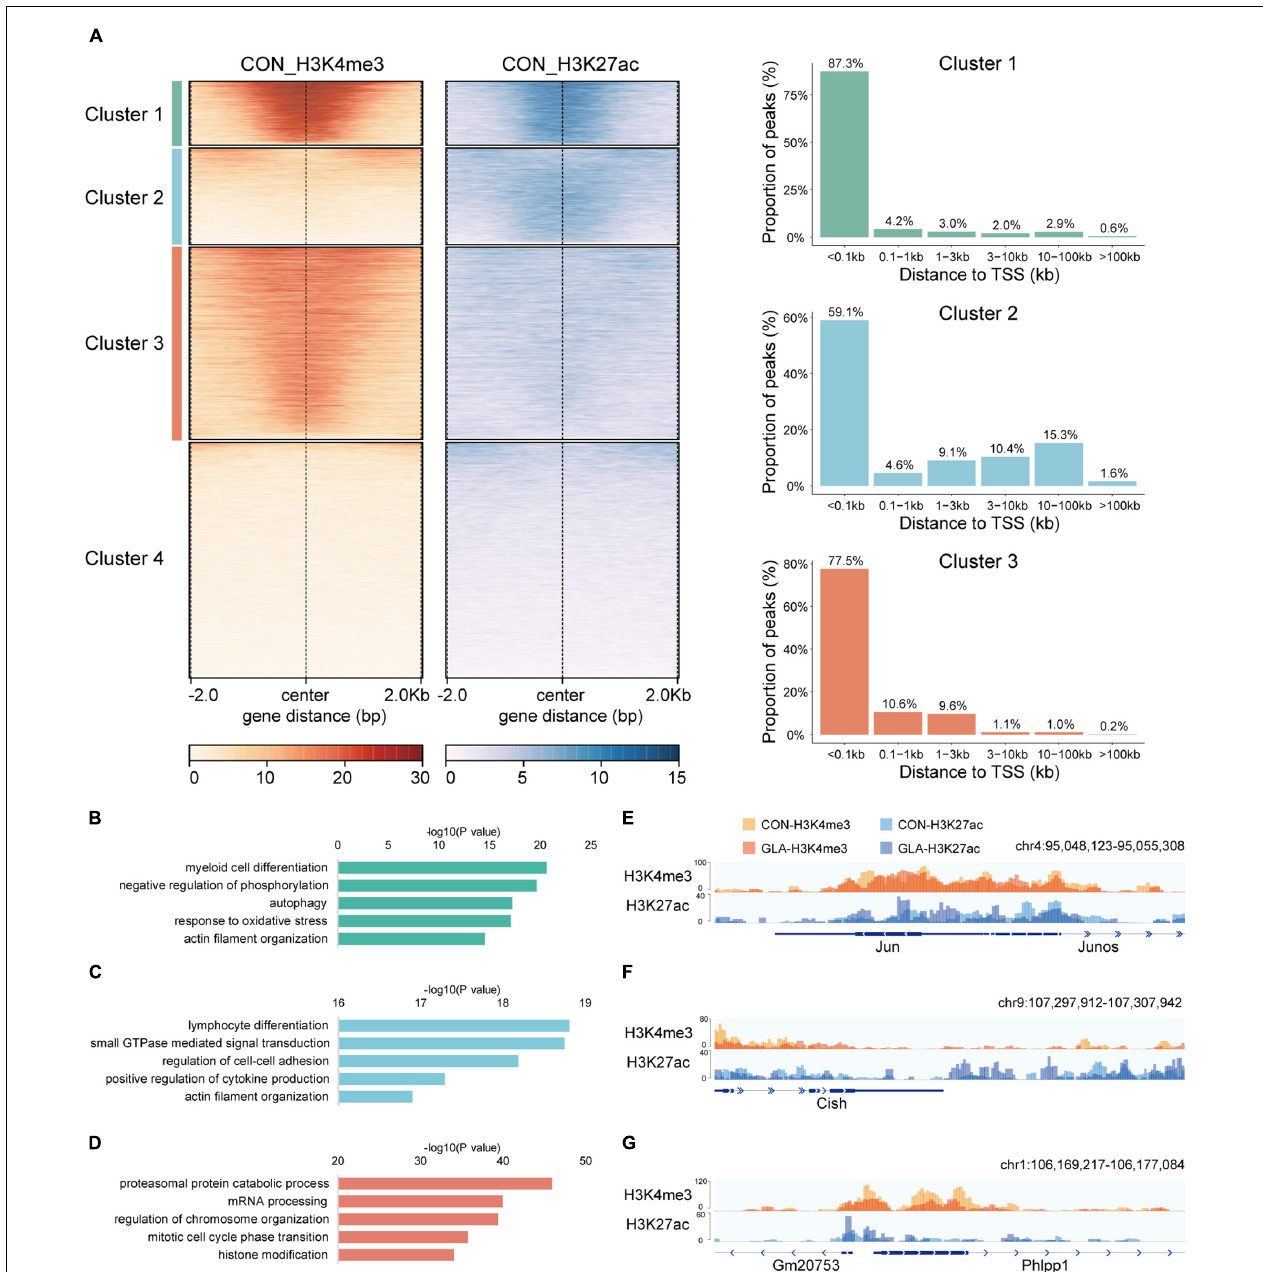
FIGURE 1 | Cluster characteristics of integrated H3K4me3 and H3K27ac in CON sperm. (A) Heatmap (left) of k-means clustering of genome-wide H3K4me3 and H3K27ac signals ± 2.0 kb the center of H3K4me3 and H3K27ac regions in CON sperm, and bar graph (right) showing distribution of regions in Cluster 1–3 relative to the nearest transcription start site (TSS). For each cluster, genes were arranged in order of decreasing signals from top to bottom. (B–D) Selected significant pathways from Gene Ontology analysis on genes from Cluster 1 (B) , Cluster 2 (C) and Cluster 3 (D) in CON sperm. (E–G) Integrative Genomics Viewer tracks showing H3K4me3 and H3K27ac signals on Jun (E) from Cluster 1, Cish (F) from Cluster 2 and Phlpp1 (G) from Cluster 3 in CON and GLA